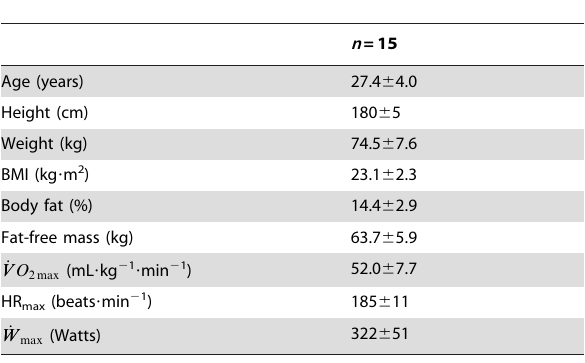
Table 1. Subject